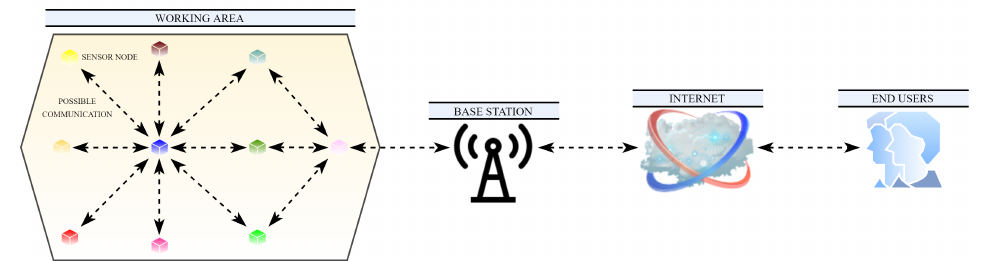
Figure 2. General architecture of wireless sensor